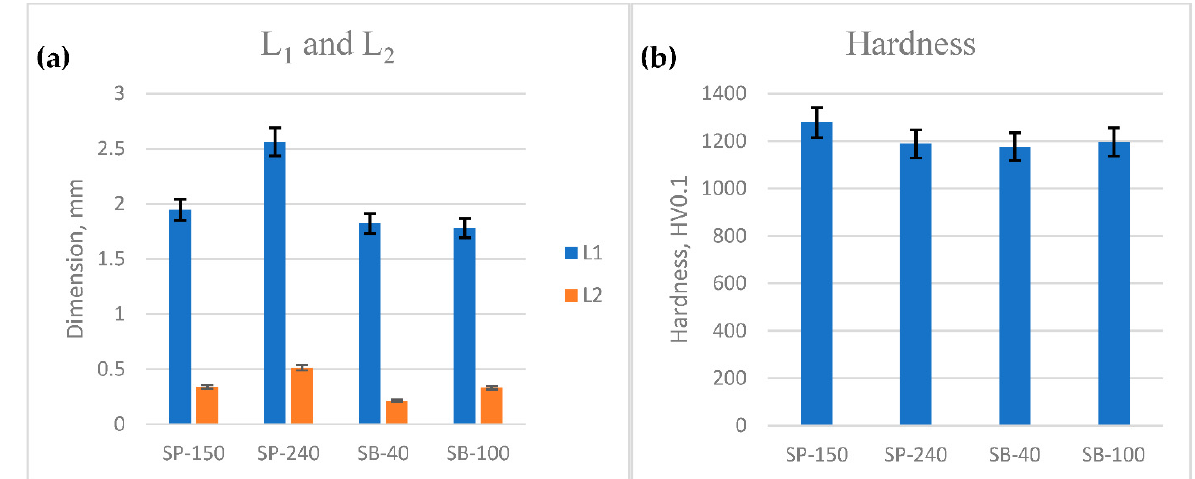
Figure 3. Experimental results of ( a ) L 1 and L 2 , ( b ) hardness of laser-cladded single track.